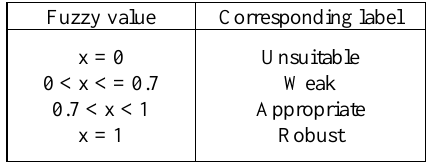
Table 1. Relation between fuzzy values and